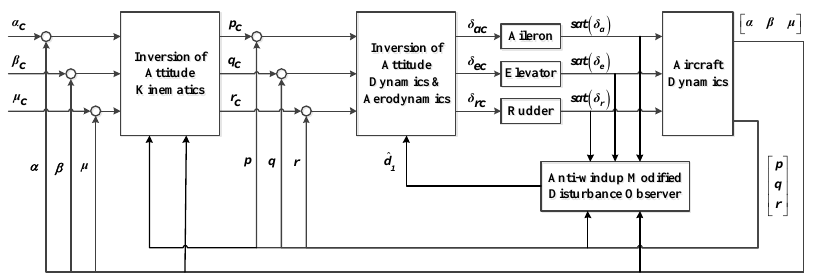
Figure 5. Anti-windup modification of the disturbance observer-enhanced NDI controller.